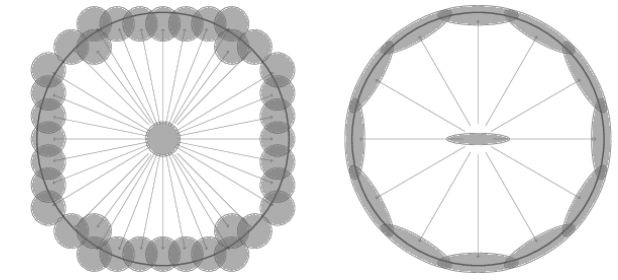
Figure 7. Schematic view of a single-scale approximation of a cir- cle with multiscale decomposition wavelet (left panel) and curvelet (right